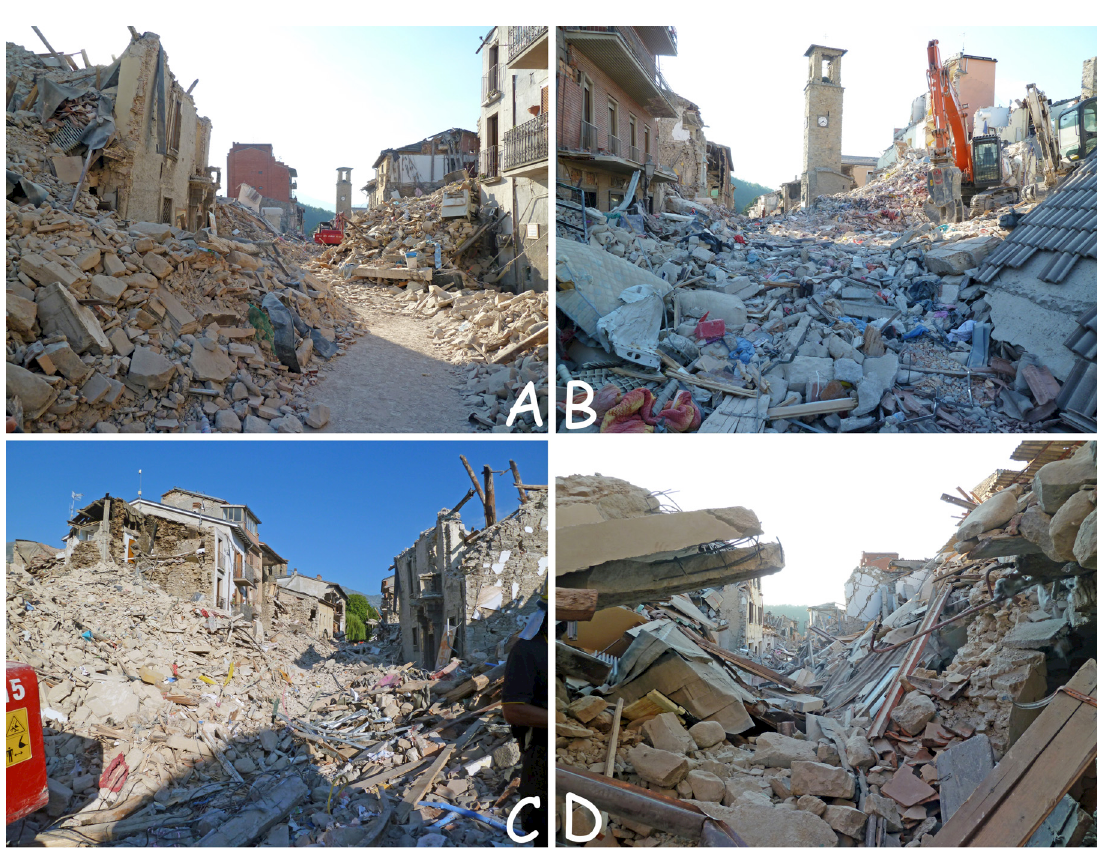
Figure 3. Views of the destroyed Amatrice downtown (10-11 MCS). A-C, Collapses of all the stone ma- sonry buildings along Corso Umberto. Note that the only still-standing buildings are the Medieval tower (A-B) - which survived also to the 1639 earthquake - and a 5-storeys RC apartment building (A; this col- lapsed during the 30 October, M 6.5 earthquake). D, View of a road paralleling Corso Umberto, with al- W most complete destruction/collapse